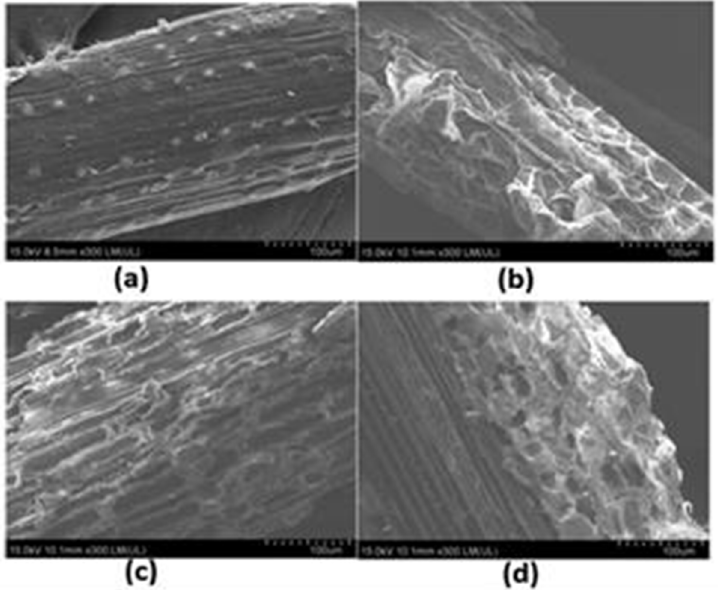
Figure 11. FE-SEM image of ( a ) Raw OPF ( b ) ChCl:urea pretreated only OPF ( c ) US pretreated only OPF (70%, 30 min) ( d ) US-DES pretreated OPF (70%, 30 min ChCl:urea). Reprinted from Ultrasonic Sonochemistry, 58, 104598, Copyright (2019), with permission from Elsevier.